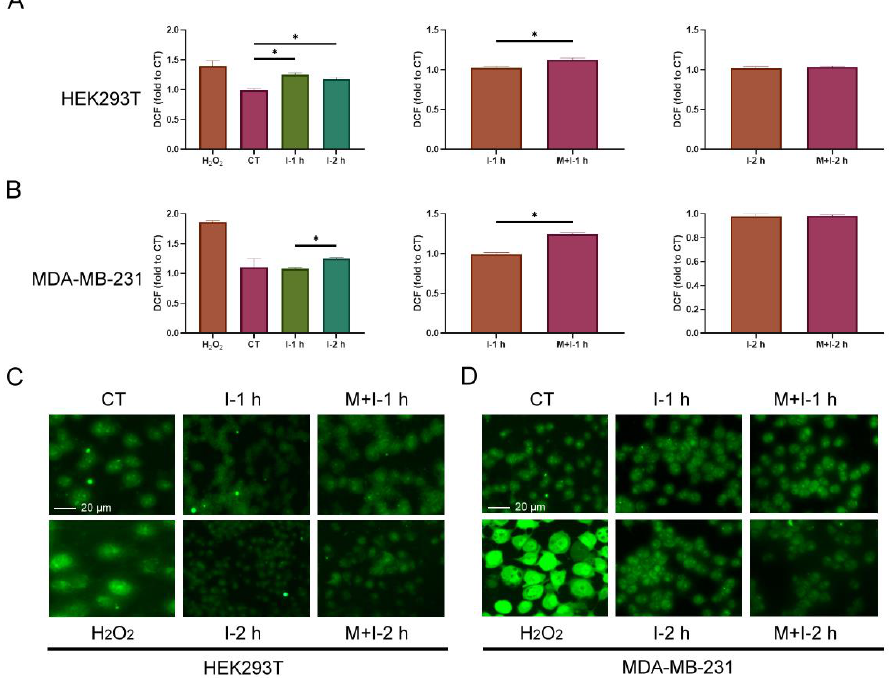
Figure 4. The change in cellular ROS in insulin or combined insulin and metformin-treated HEK293T and MDA-MB-231 cells. The cellular ROS in ( A ) HEK293T and ( B ) MDA-MB-231 cells with each indicated treatment determined by flow cytometry. The fluorescence microscopy image of cellular ROS in ( C ) HEK293T and ( D ) MDA-MB-231 cells with each indicated treatment. CT: control; I: 10 ng/mL insulin; M + I: 10 mM metformin (15 mM metformin for MDA-MB-231 cells) + 10 ng/mL insulin; H 2 O 2 : 0.5 mM H 2 O 2 . The results with significant difference at p < 0.05 are indicated by * ( n = 3). The fold change in DCF was derived from dividing the fluorescence intensity from each sample by that from one of CT sample.